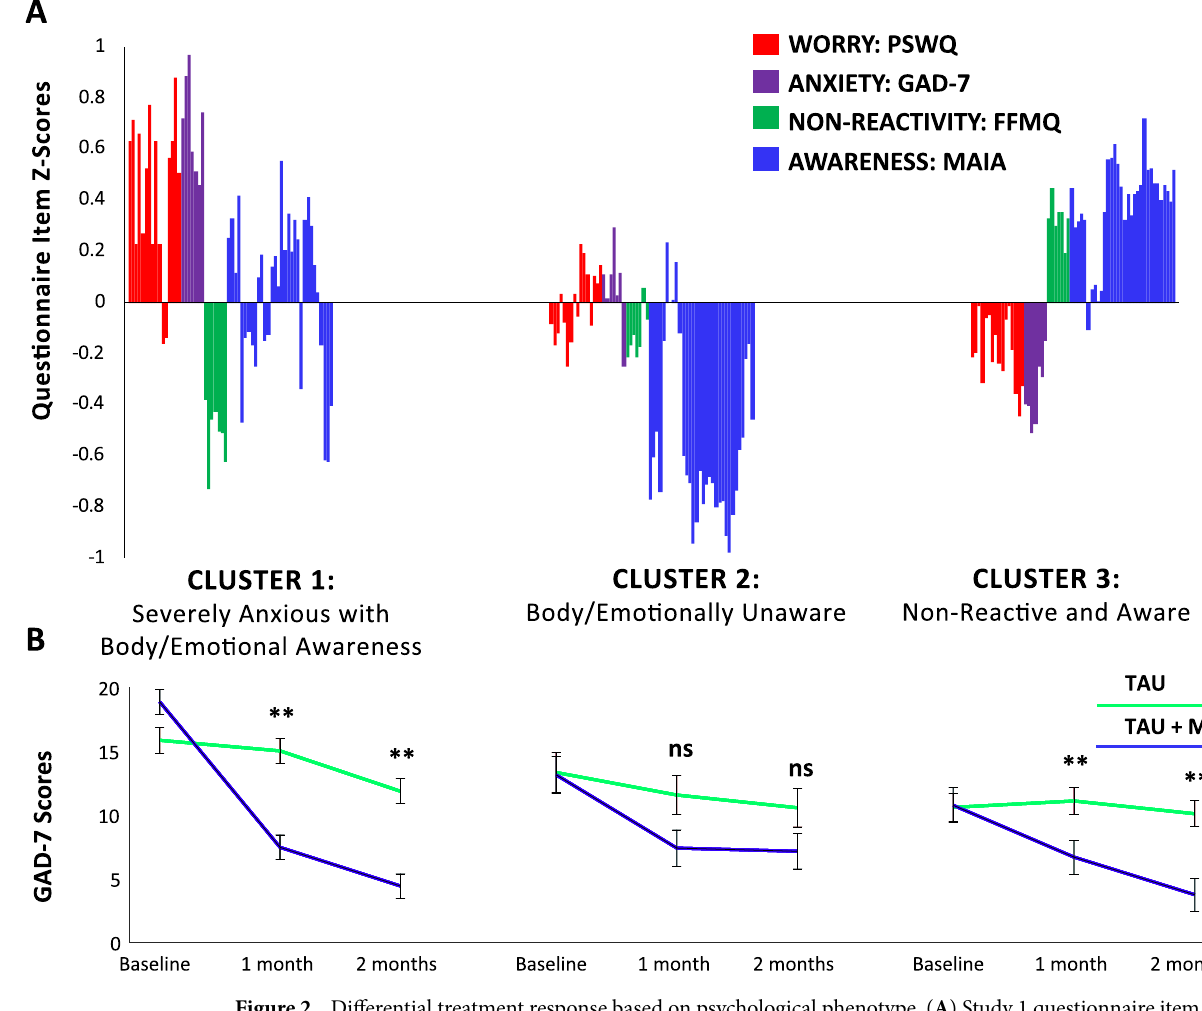
Figure 2. Differential treatment response based on psychological phenotype. ( A ) Study 1 questionnaire item z-scores are shown for Cluster 1 (n = 13), Cluster 2 (n = 21), and Cluster 3 (n = 29): PSWQ: Penn State Worry Questionnaire (red); GAD-7: Generalized Anxiety Disorder 7-item Scale (purple): FFMQ: Non-Reactivity Subscale of the Five Facet Mindfulness Questionnaire (green); MAIA: Multidimensional Assessment of Interoceptive Awareness (blue). ( B ) Study 1 GAD-7 scores are shown at each assessment timepoint (baseline, 1 and 2 months post-treatment initiation) for clusters 1, 2, and 3 (TAU + MT = treatment as usual + mindfulness training; TAU = treatment as usual). Means are shown with standard error, and asterisks denote significant group differences at each assessment timepoint (relative to baseline) as follow-up contrasts from mixed measures ANOVA. ** p < 0.001; ns: